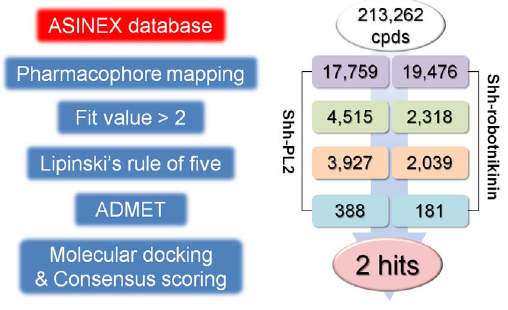
Figure 5. Flow chart of virtual screening procedure used in the